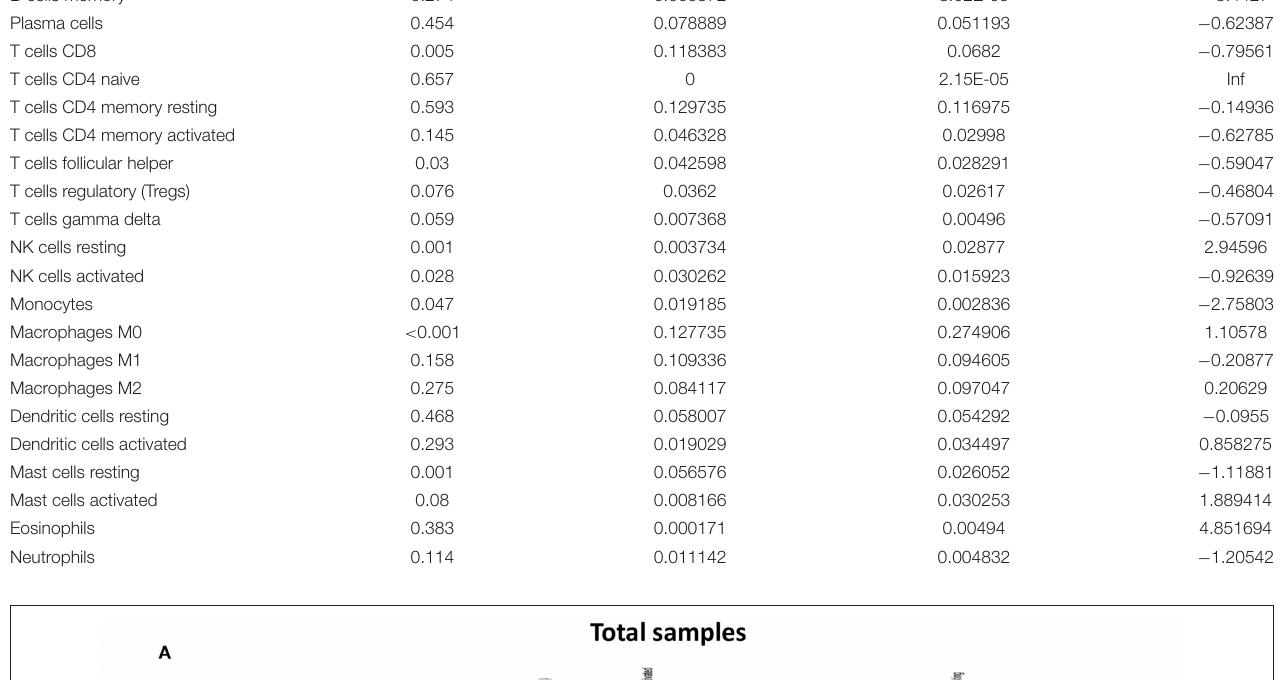
TABLE 1 | Comparison of CIBERSORT immune fractions between HNC tumor tissues and adjacent tissues.